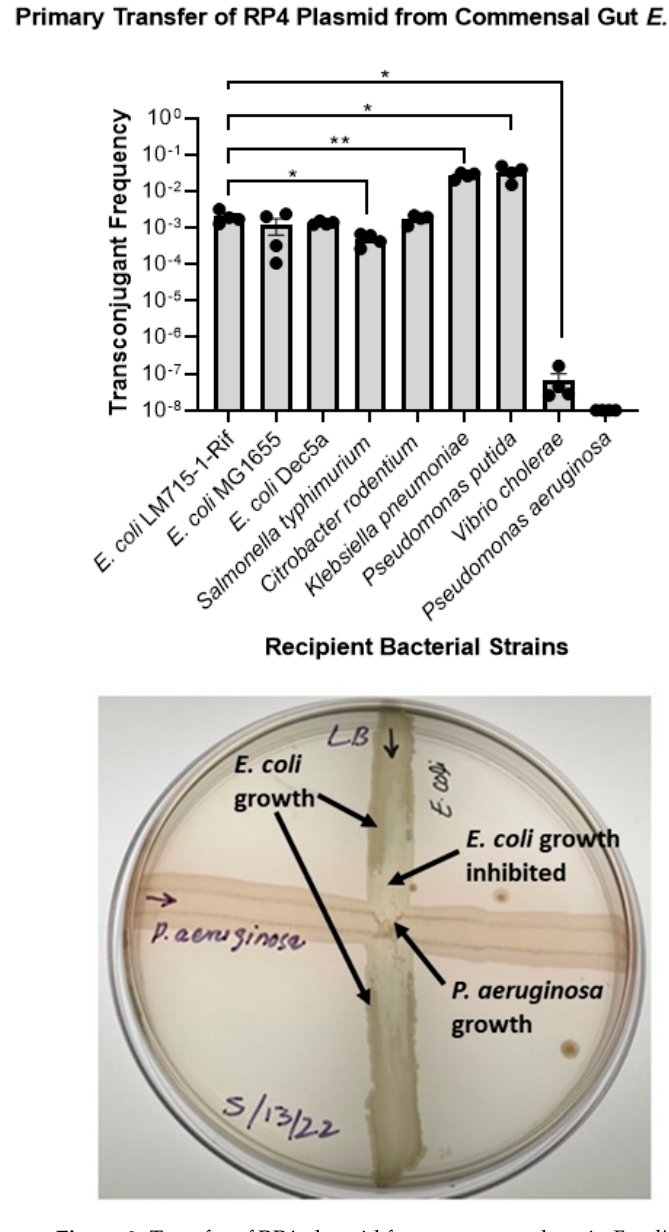
Figure 2. Transfer of RP4 plasmid from commensal strain E. coli LM715-1 to multiple recipient bacteria and inhibition by P. aeruginosa . ( A ) Plasmid transfer frequencies for all recipients were calculated using the formula (plasmid transfer frequency = transconjugants/(transconjugants + recipients)). Bars show mean values ± standard error of the mean (SEM) based on four independent replicates (n = 4) performed for each conjugation experiment. Plasmid transfer frequencies from E. coli LM715-1:RP4 to all other isolates were compared to the plasmid transfer frequency from E. coli 715-1:RP4 to E. coli LM715-1 RifR. We used Welch’s t -test instead of an unpaired independent samples t- test if there was unequal variance between compared groups to calculate p values. Only significant p values are annotated in the graph: * = p ≤ 0.05, ** = p ≤ 0.01. The transfer frequency was not detected for the conjugation experiment of donor strain E. coli LM715-1 with P. aeruginosa . ( B ) Growth-inhibitory activity of P. aeruginosa against commensal strain E. coli LM715-1; zones of growth and inhibition are indicated by arrows. E. coli LM715-1 diminishes close to the intersection compared to the corners of the streak, whereas P. aeruginosa growth remains intact.